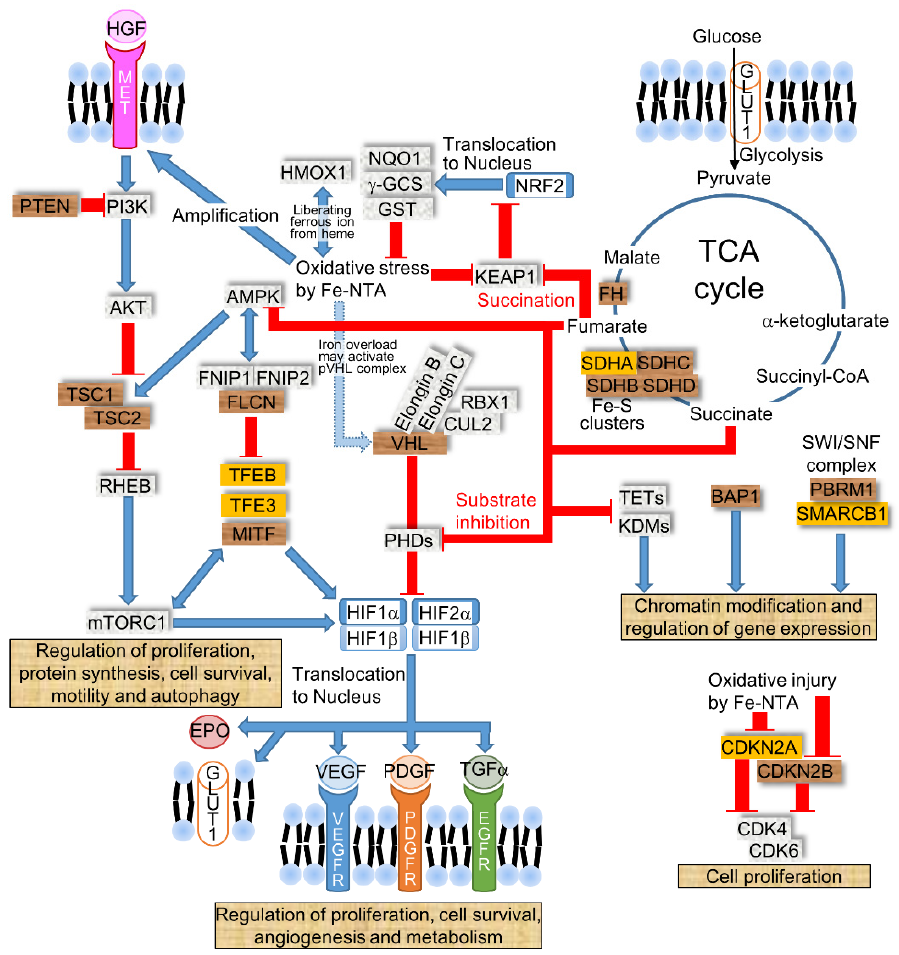
Figure 2. The dysregulated signaling pathways in RCC. RCC is caused by several signaling pathways, such as HIF, MET kinase, mTOR, TCA cycle, cell cycle regulation, and chromatin modification and regulation. Brown tags represent a gene that causes RCC via germline or somatic alterations, such as VHL ( von Hippel–Lindau ), BAP1 ( BRCA1-associated protein 1 ), PBRM1 ( polybromo 1 ), MET , PTEN ( phosphatase and tensin homolog ), TSC1/2 ( tuberous sclerosis 1/2 ), FLCN ( folliculin ), MiTF ( microphthalmia-associated transcription factor ), SDHB/C/D ( succinate dehydrogenase B/C/D ), FH ( fumarate hydratase ), and CDKN2B ( cyclin-dependent kinase inhibitor 2B ). Orange tags represent a gene that is frequently mutated in sporadic RCCs, such as SDHA , TFEB ( transcriptional factor EB ), TFE3 ( transcriptional factor E3 ), SMARCB1 , and CDKN2A . The blue arrow indicates the activation pathway, and the red line indicates signal transduction suppression. Acronyms: PHDs (prolyl hydroxylases), HGF (hepatocyte growth factor), EPO (erythropoietin), AMPK (AMP-activated protein kinase), FNIP1/2 (folliculin-interacting protein 1/2), RHEB (ras-homolog expressed in brain), VEGF (vascular endothelial growth factor), PDGF (platelet-derived growth factor), TETs (ten-eleven translocations), and KDMs (lysine-specific